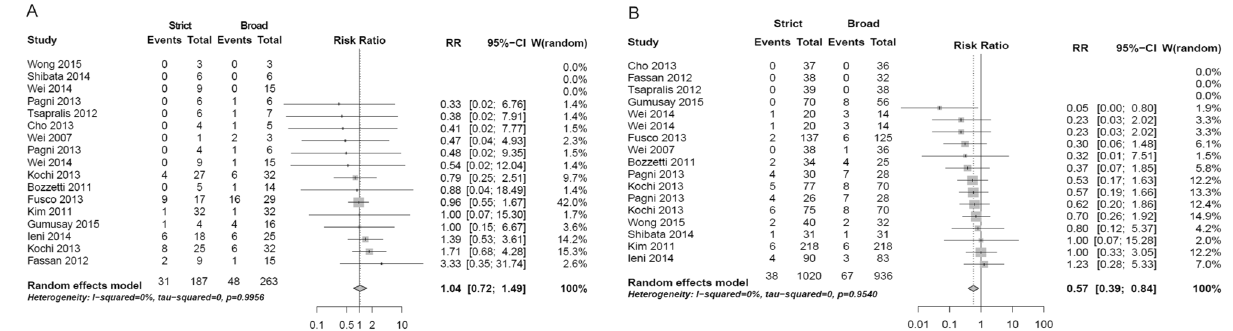
Figure 3. Random-effect pair-wise meta-analyses of ( A ). Positive to negative HER2 status discordance (negative conversion) of strict vs. broad methods of HER2 detection ( B ). Negative to positive HER2 status discordance (positive conversion) of strict vs. broad methods of HER2 detection.